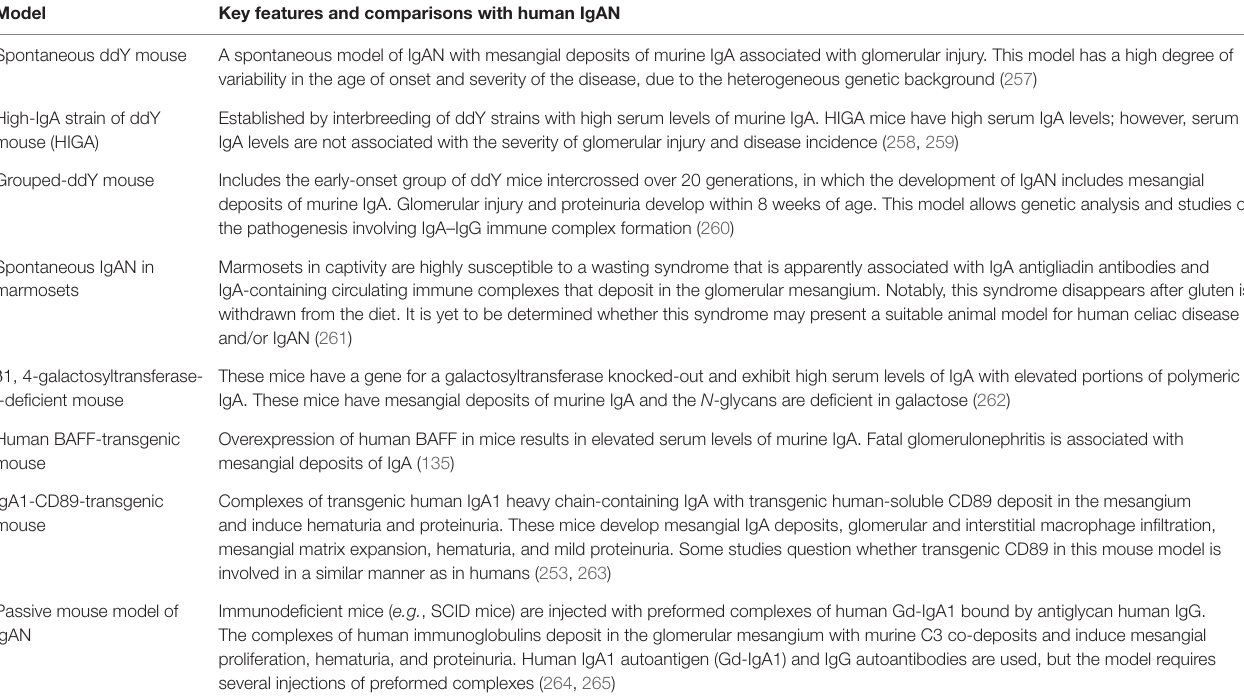
TABLe 1 | Selected animal models of igAN. Model Key features and comparisons with human